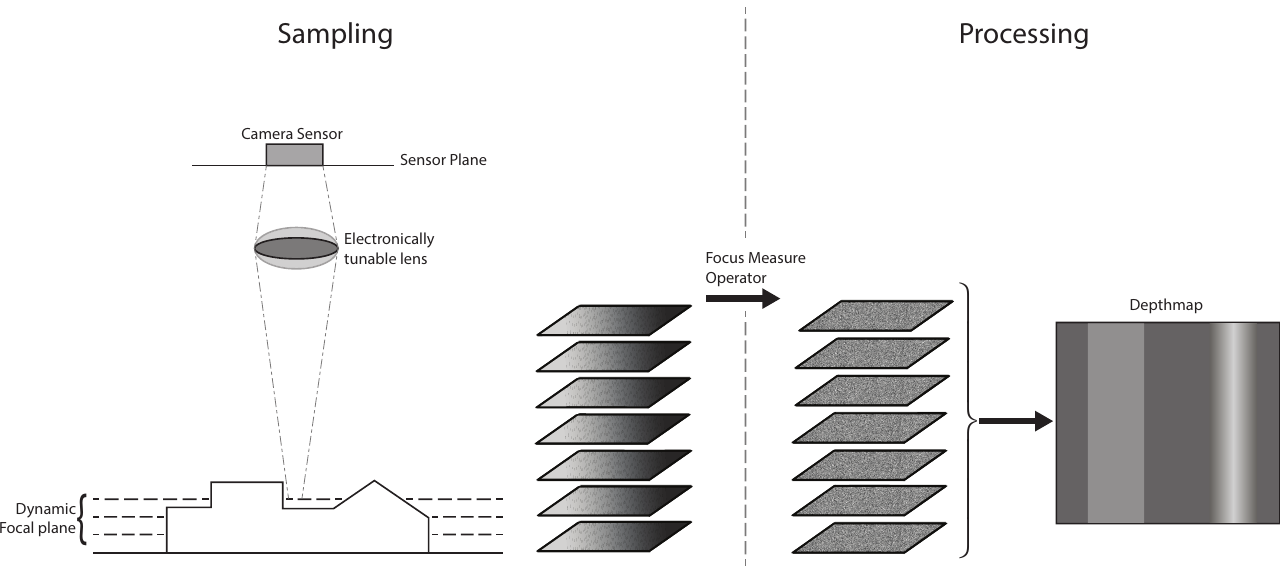
Figure 2. SFF sampling and processing using an ETL. The ETL is controlled to change the focal distance between ev- ery captured frame. All frames are then processed using the FMO, the result of this process is then converted in a depth map by either converting the image number of the image with the highest response to the FMO to a depth or by gaussian